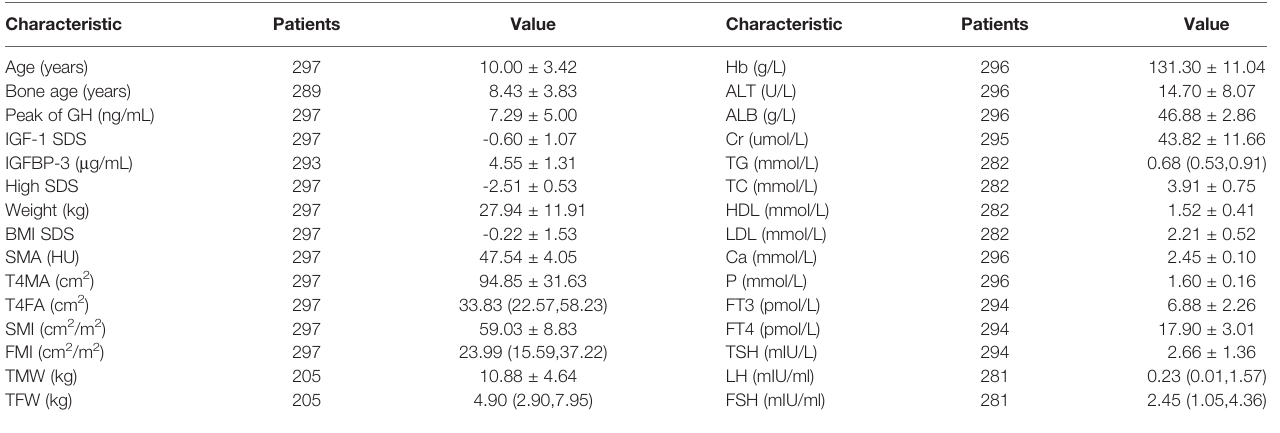
TABLE 1 | Characteristics of patients included in this